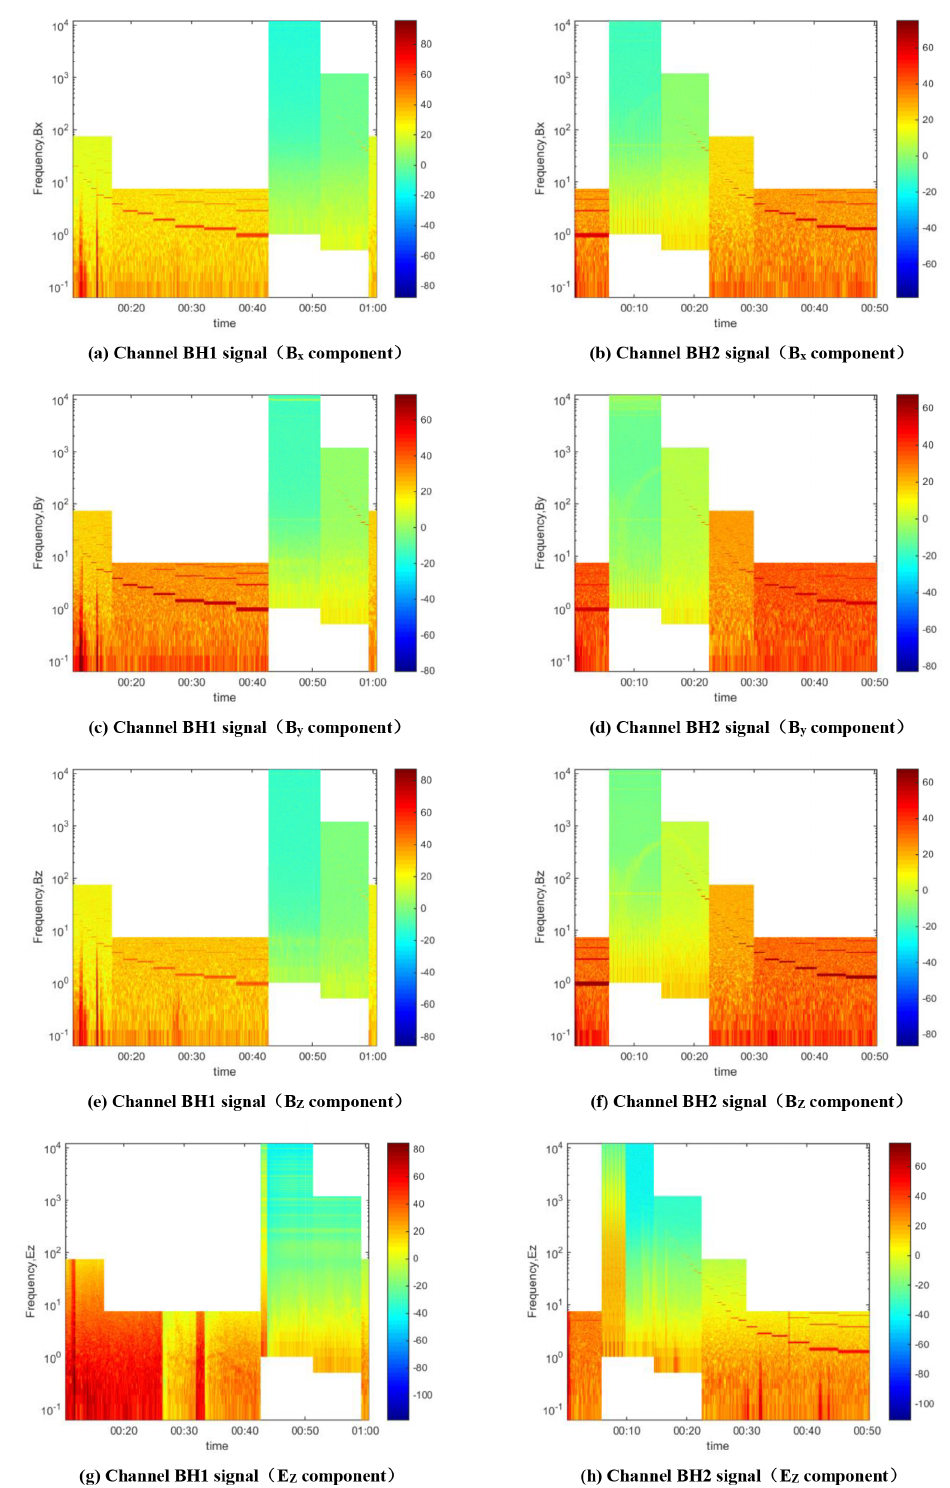
Figure 10. Time–frequency spectra. The scale in the figures is provided in dB; however, the data in the figure are calculated using the formula 10log X . The units of the time and frequency are minutes (hh:mm) and Hz, respectively. Owing to the malfunction of the electrode, no obvious signal can be seen in the E z component of